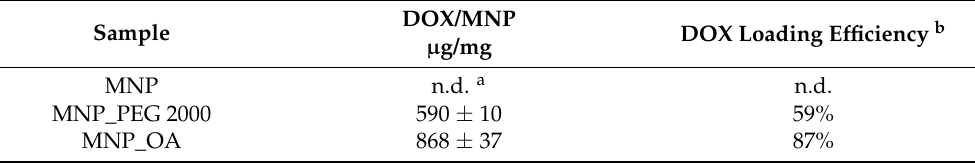
Table 2. The comparison of the DOX loading MNP